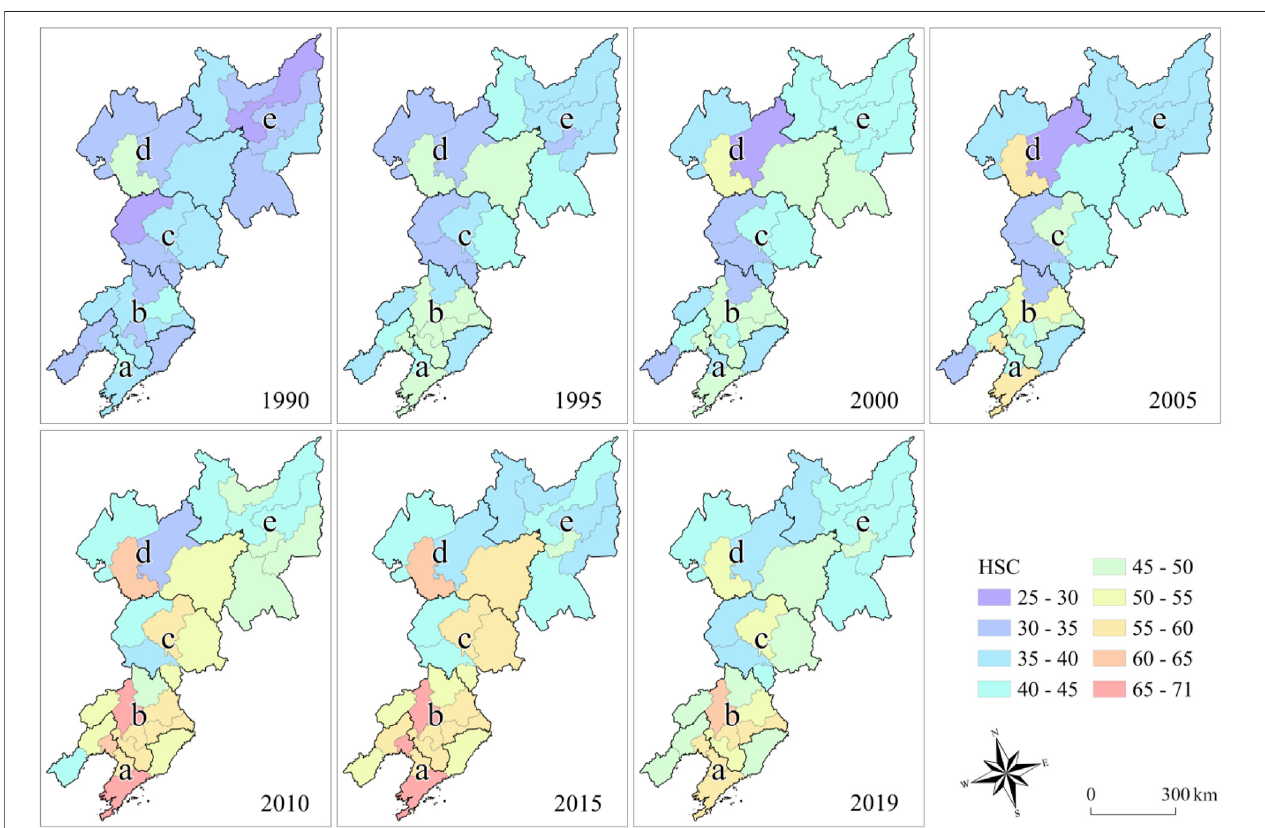
FIGURE 4 | Spatial and temporal patterns of human settlement